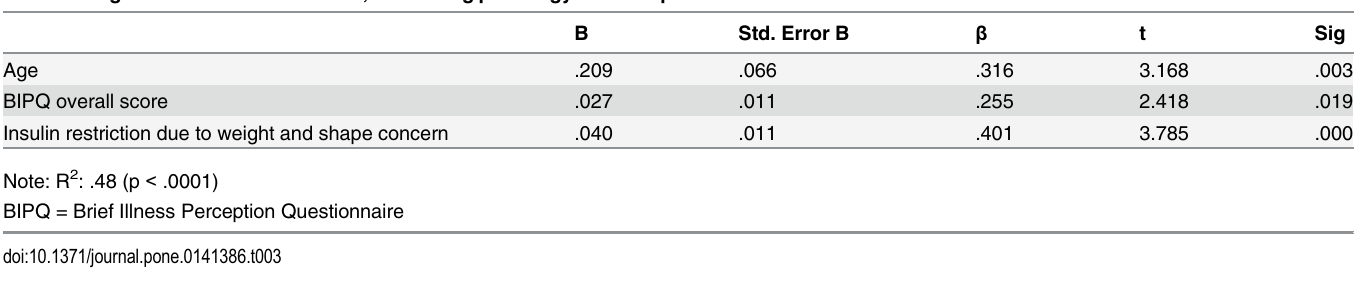
Table 3. Regression model for females, with eating pathology as the dependent